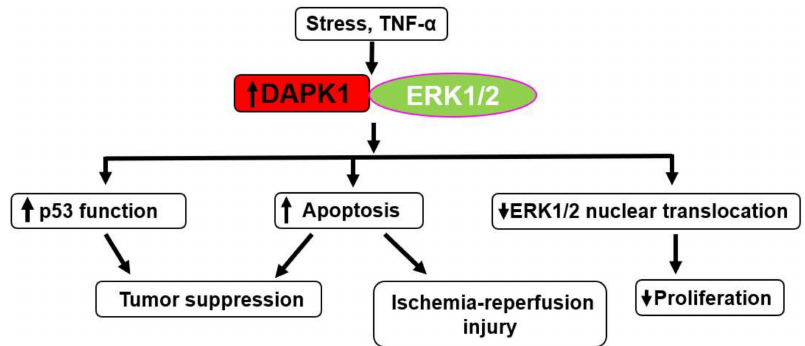
Figure 3. Interaction between DAPK1 and extracellular signal-regulated kinase (ERK)1/2. DAPK1-ERK1/2 interaction promotes tumor suppression and ischemia-reperfusion injury through upregulation of p53 function or propagating apoptosis. It also inhibits cell proliferation through prevention of ERK1/2 nuclear translocation. TNF = tumor necrosis factor. Up arrow indicates the increased responses, expression of protein and activity. Signal arrow indicates the promotional